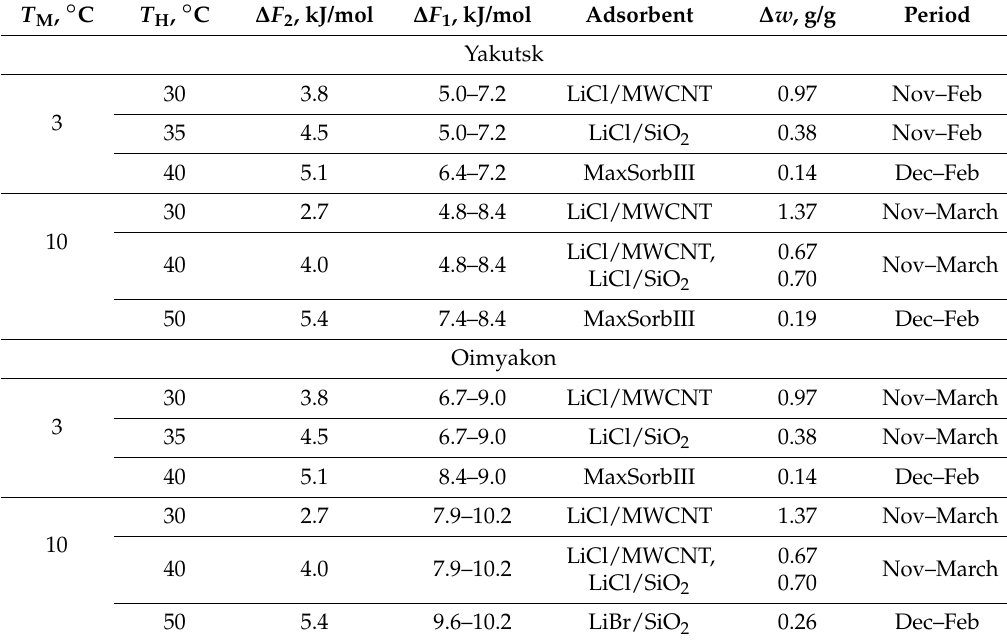
Table 4. The boundary conditions, the promising adsorbents, and the mass of exchanged methanol for the HeCol cycle